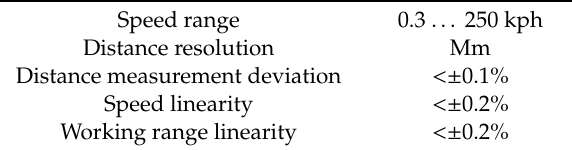
Table 3. Datron L-350 Aqua